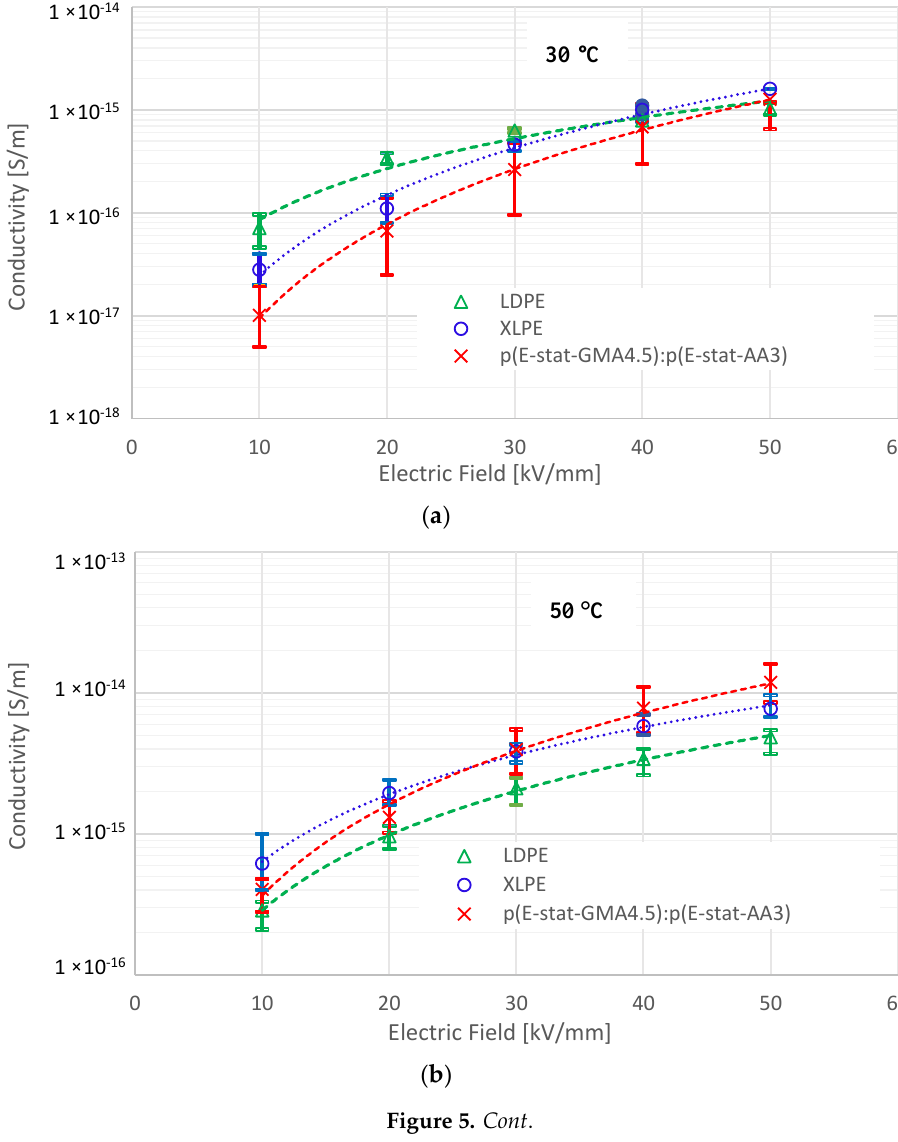
Figure 4. Surface potential as a function of time for crosslinked polyethylene (XLPE); red triangular symbols represent selected data points for conductivity